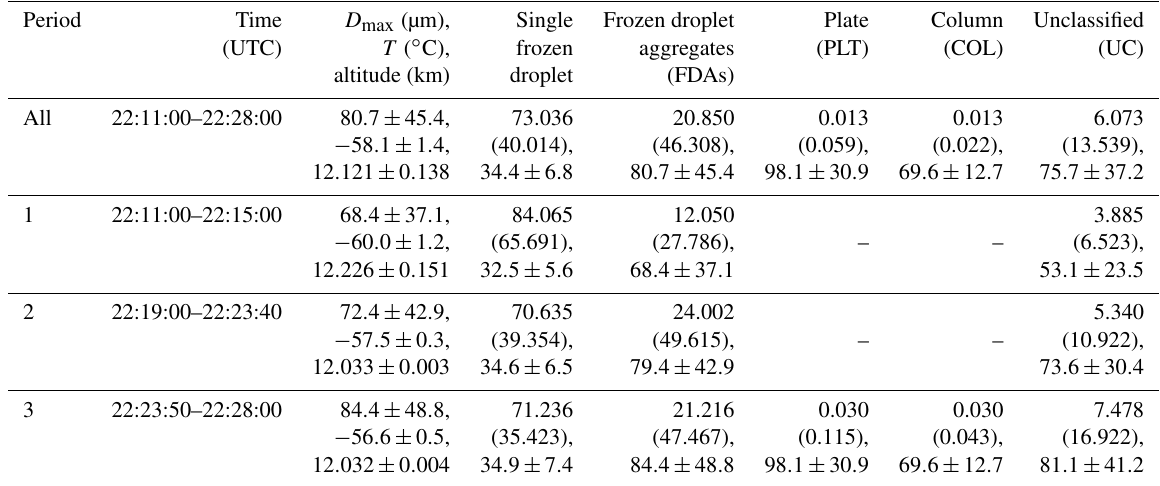
Table 1. Segregated time periods of the 6 June flight and contributions (%) of crystal habit to the total number (total projected area) of ice crystals for the given time period. The average and standard deviation of temperature ( T ), altitude, and maximum dimension ( D max ) of ice crystals determined from CPI images are also listed for the given time period. Period Single Frozen droplet